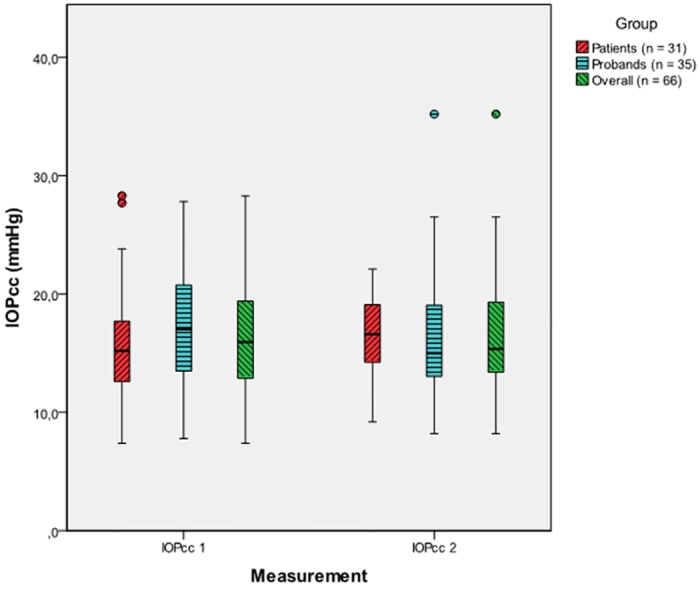
Tonographic effect from the first (IOPcc 1) to the second (IOPcc 2) IOPcc measurement for patients, probands and the overall sample (patients and probands combined), [mmHg].